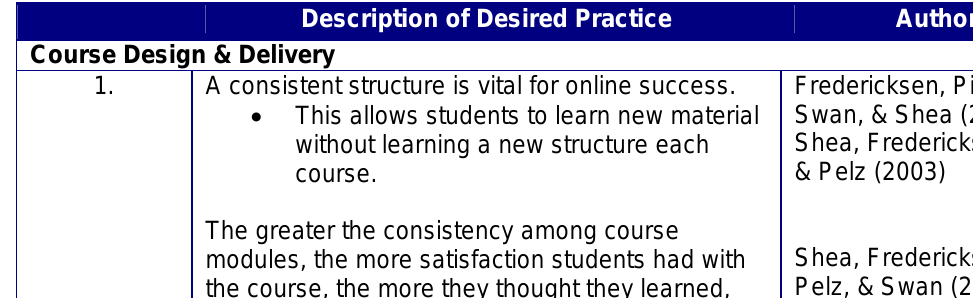
Table 2. Online Education Best